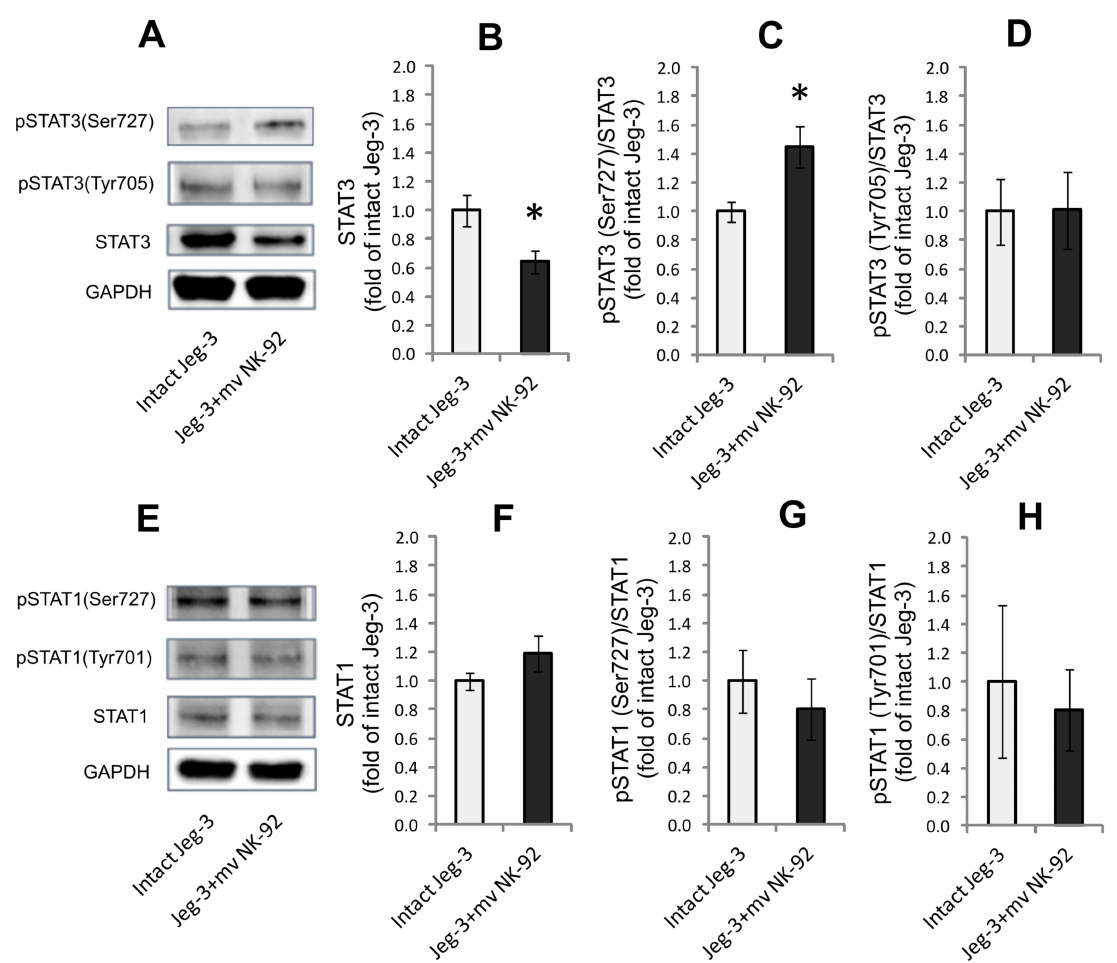
Figure 6. Effect of NK-92 cell MVs on content of STAT1 and STAT3 proteins and their phosphorylated forms in JEG-3 cell lysates. Immunoblot shows content of ( A ) STAT3 and ( E ) STAT1 in intact JEG-3 cells and after their interaction with NK-92 cell MVs. Band density of ( B ) total STAT3 and ( F ) STAT1 content in intact JEG-3 cells and after interaction with NK-92 cell MVs, normalized by GAPDH. Ratio of ( C , D ) phospho-STAT3 (pSTAT3(Ser727), pSTAT3(Tyr(705)) and total STAT3 (n = 3) and ( G , H ) phospho-STAT1 (pSTAT1(Ser727), pSTAT1(Tyr(701)) and total STAT1 (n = 4) in studied samples. Significant differences between JEG-3 cells treated with NK-92 cell MVs and intact JEG-3 cells: * p <